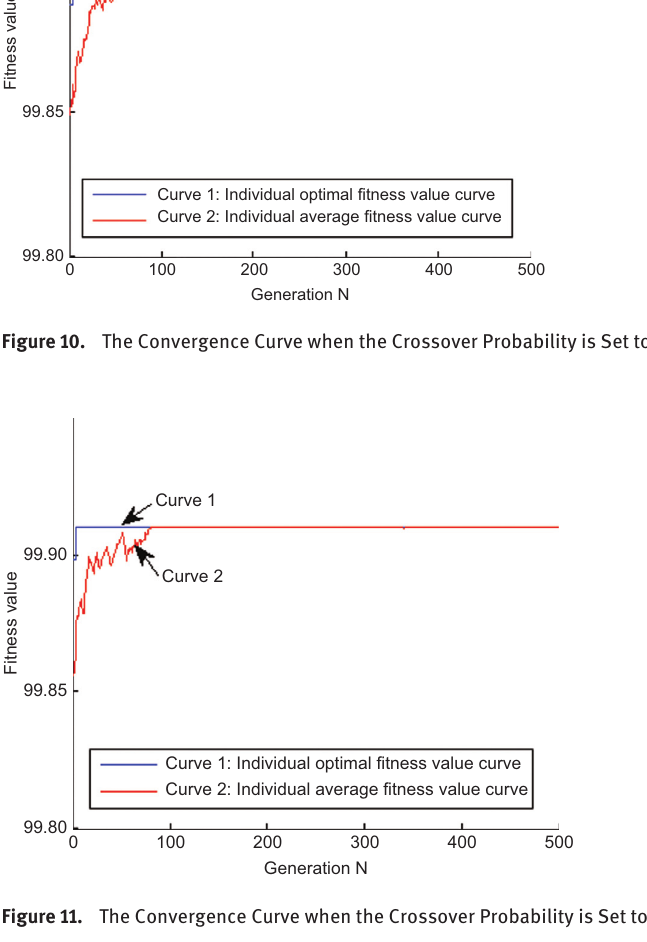
Figure 11. The Convergence Curve when the Crossover Probability is Set to (0.8, 0.6). The Results are Shown in Table 4.